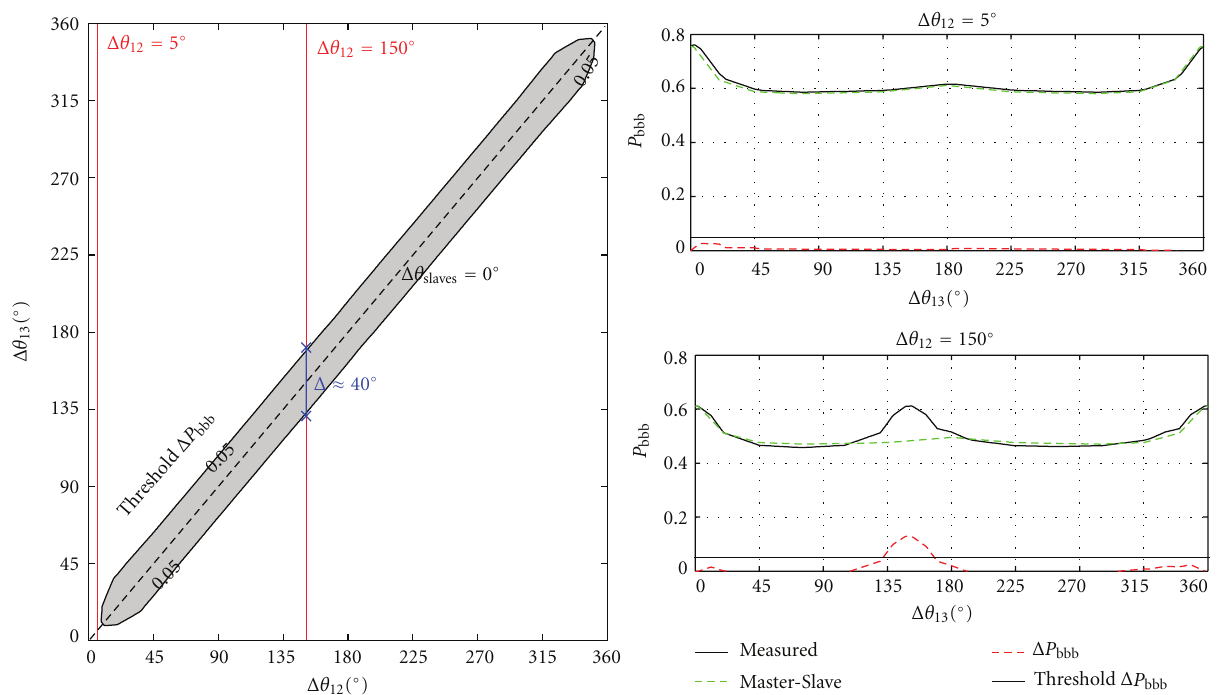
Figure 16: Left: Inappropriate Master-Slave constellations (grey field) with dependency on the azimuth angle separations between master and slaves ( Δ θ 12 and Δ θ 13 ) for φ 1 = φ 2 = φ 3 = 15 ◦ . They are assumed for Δ P bbb > 0 . 05 (cf. Figure 11). Right: Assuming satellite 2 has position Δ θ 12 = 5 ◦ , then there is no constraint for the position of satellite 3 ( Δ θ 13 ). Assuming satellite 2 has position Δ θ 12 = 150 ◦ , then satellite 3 with 130 ◦ ≤ Δ θ 13 ≤ 170 ◦ is inappropriate for Master-Slave.